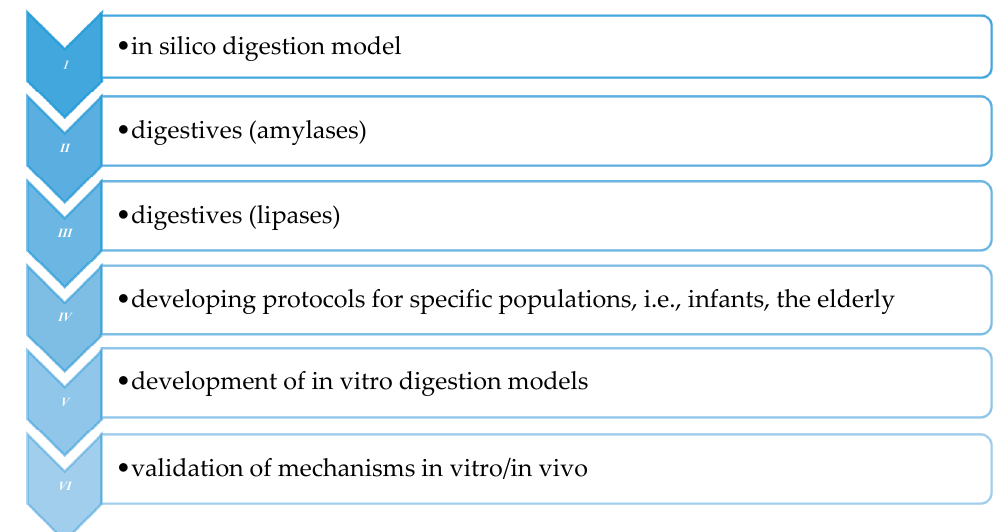
Figure 2. The main directions of research on the mechanisms of food digestion in order to release bioactive substances.